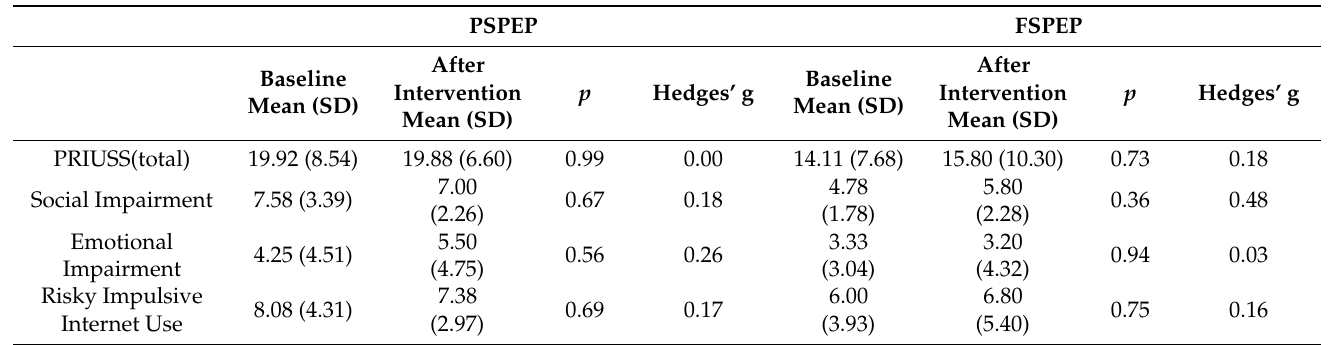
Table 4. RPIUSS test